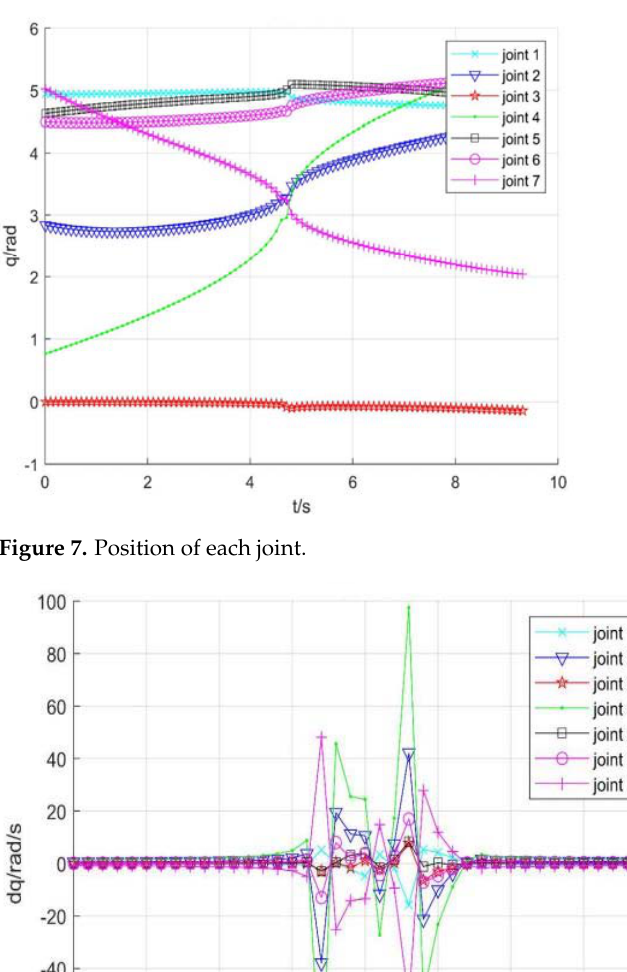
Figure 6. Numerical inverse solution error.